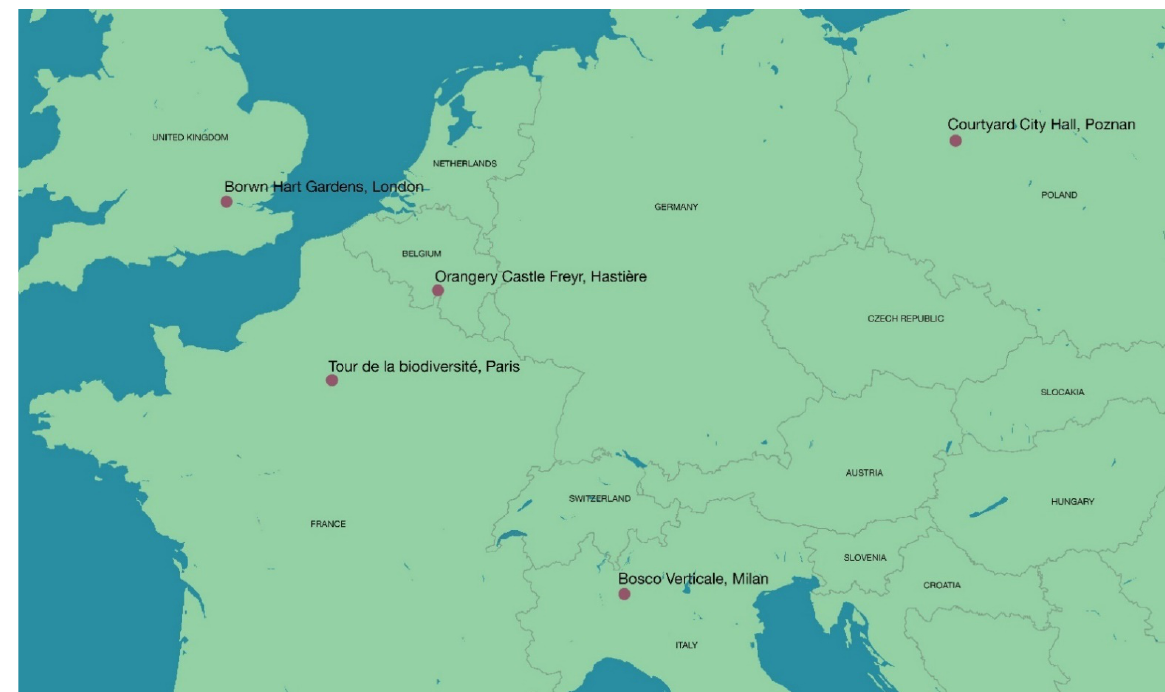
Figure 2. Location of the five selected projects in Europe. (Own graphic based on https://www.openstreetmap.de/karte/ (accessed on 15 July 2022)).